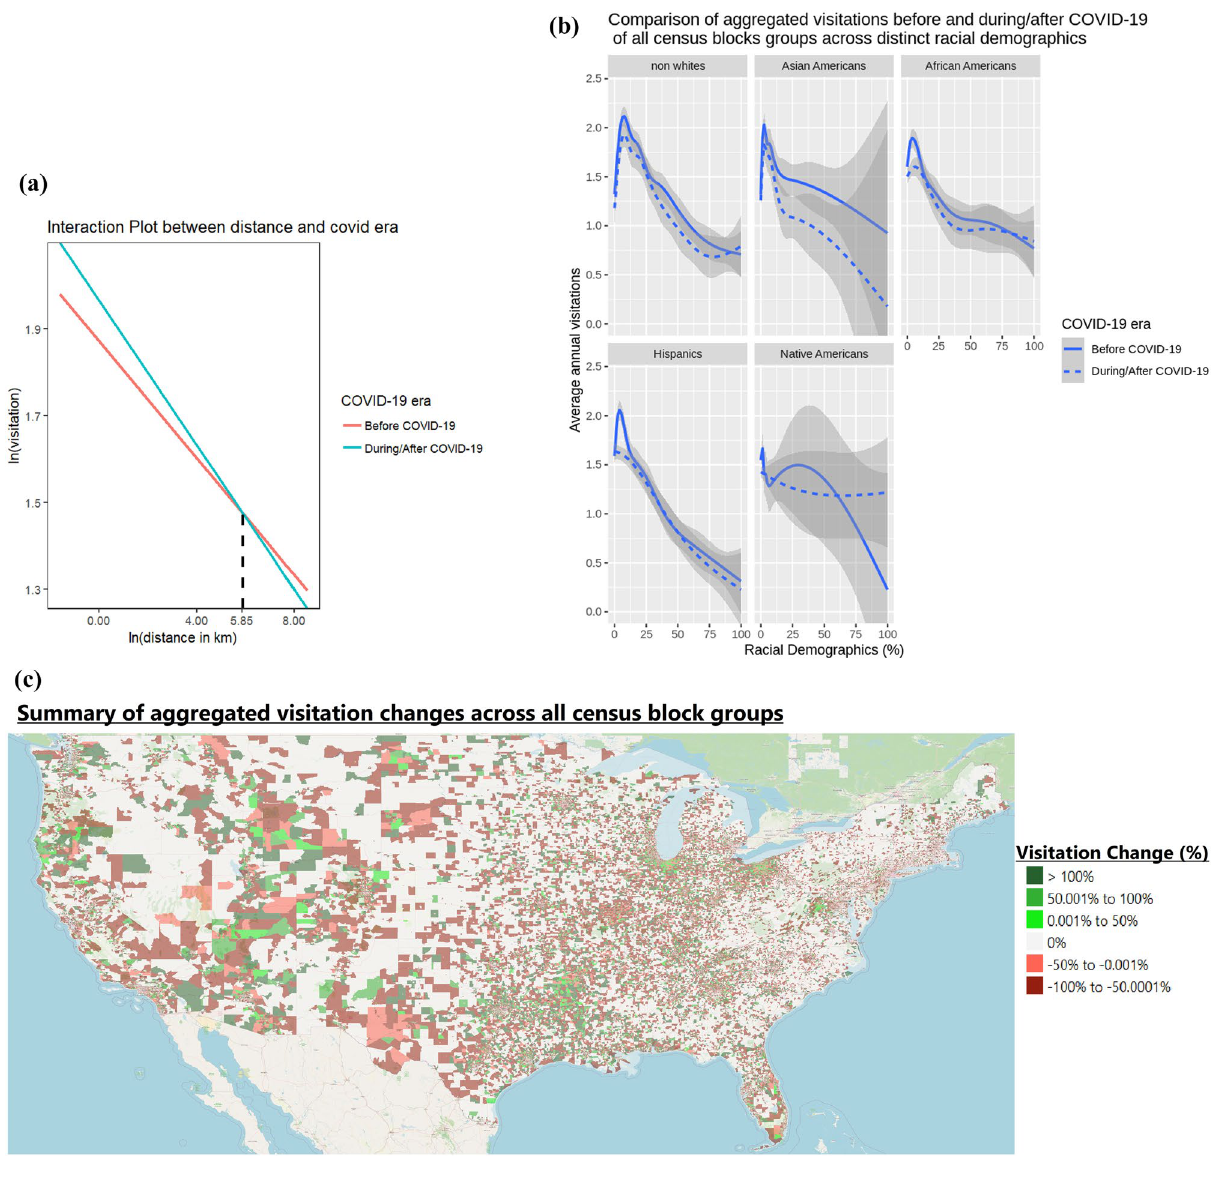
Figure 2. Visualizations of the overall impact of COVID-19 towards park visitations. ( a ) on the left reflects the interaction plot between distance and COVID-era. ( b ) On the top-right, reflects the impact of annually aggregated visitations across distinct racial demographics due to COVID-19. ( c ) On the bottom-right, maps the overall impact of COVID-19 on visitations from all census block groups across contingent USA. The map was generated using QGIS 25 , with the map layers being facilitated by OpenStreetMaps 26